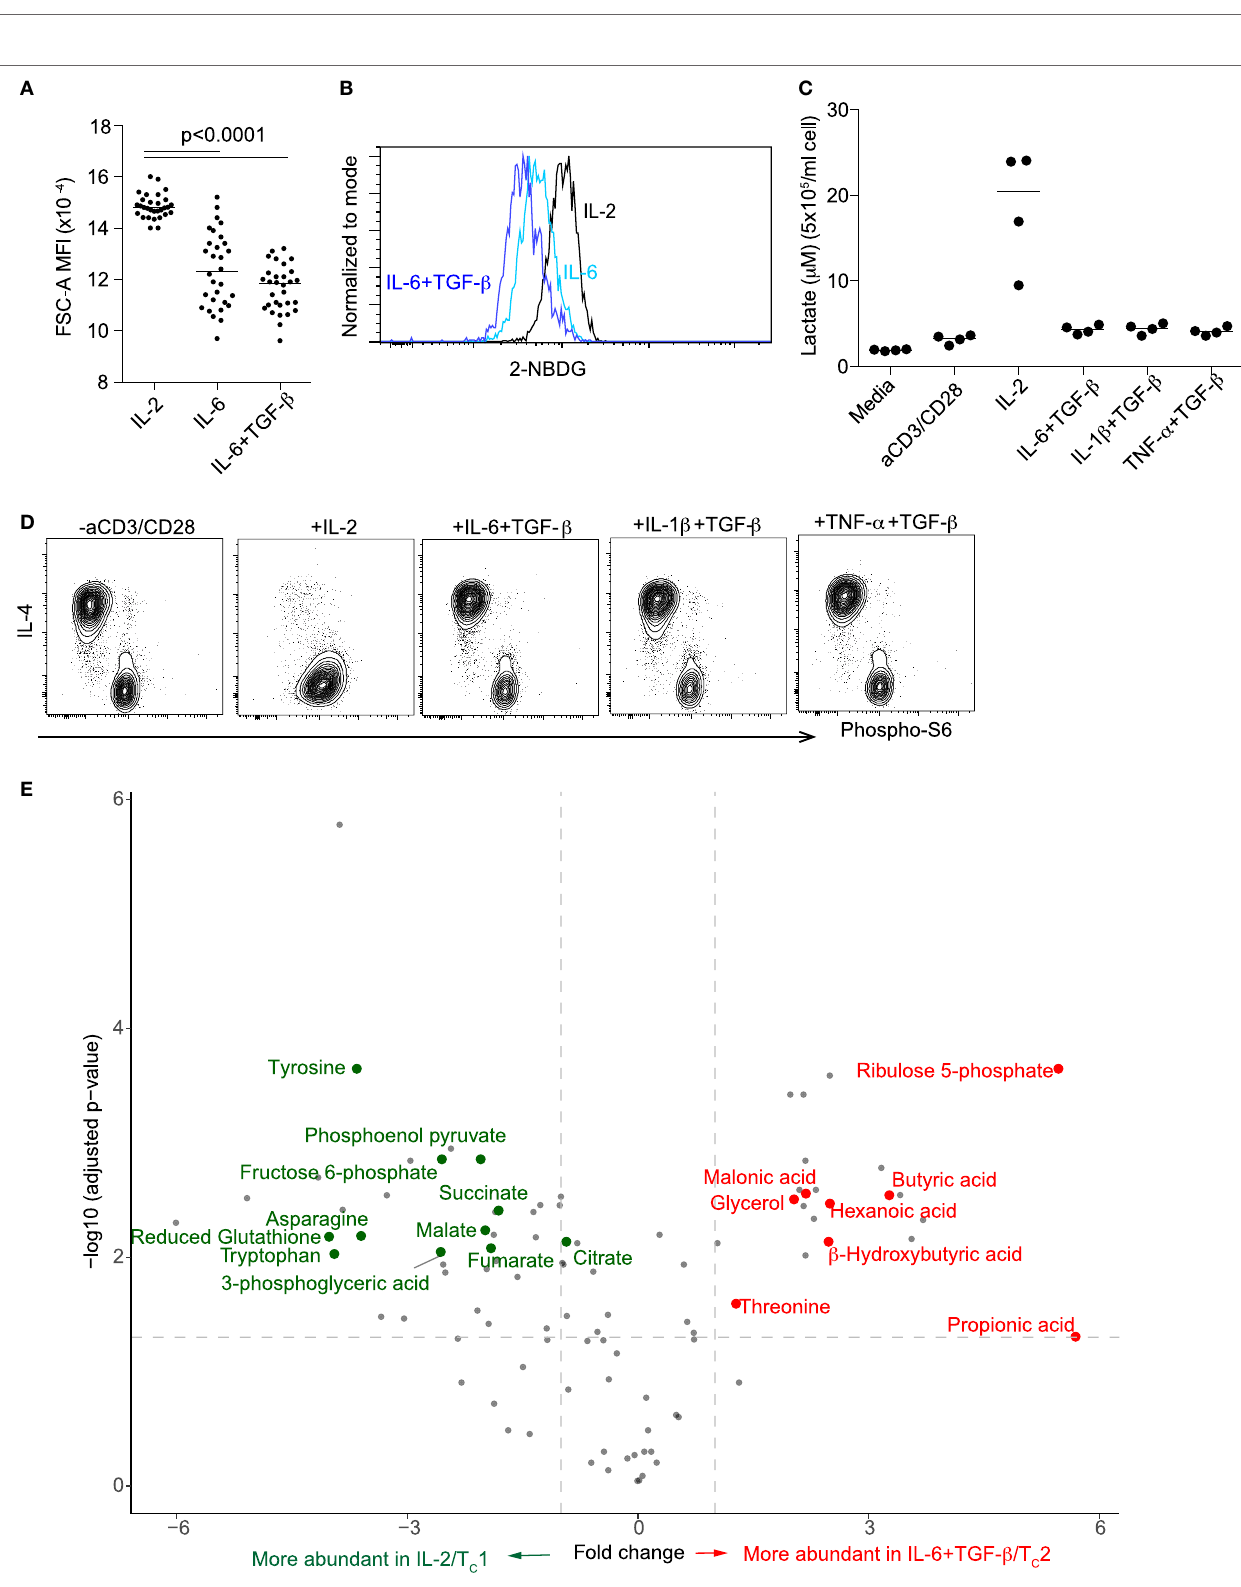
FigUre 5 | Differentiation of “T C 2” cells is associated with decreased glycolysis. Cell size (a) , glucose uptake (B) and secretion of lactate (c) after activation of CD8 + T cells under T C 1 or “T C 2” conditions. All parameters of glycolysis were decreased under “T C 2” conditions. (D) Decreased phosphorylation of S6, an mTOR substrate, associated with expression of IL-4. (e) Metabolites in CD8 + T cells that were activated under T C 1/IL-2 and IL-6 + TGF- β /“T C 2” conditions. Data are representative of three independent